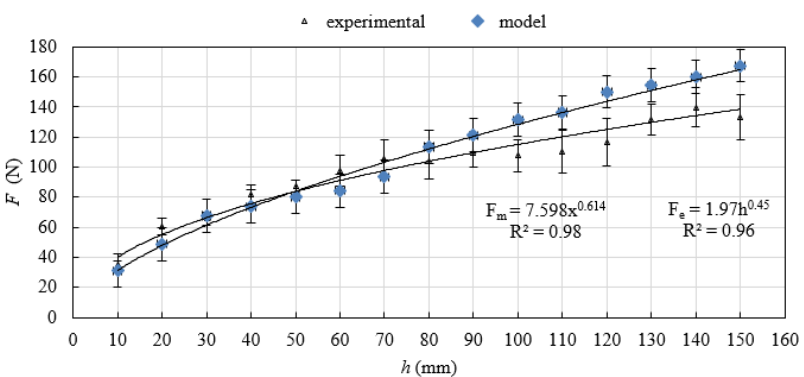
Figure 11. Influence of the drop height on the experimental and model force value, for wood type substrates. Fm — means model force, Fe — means experimental force. Error bars represent mean ± SD (standard deviation).